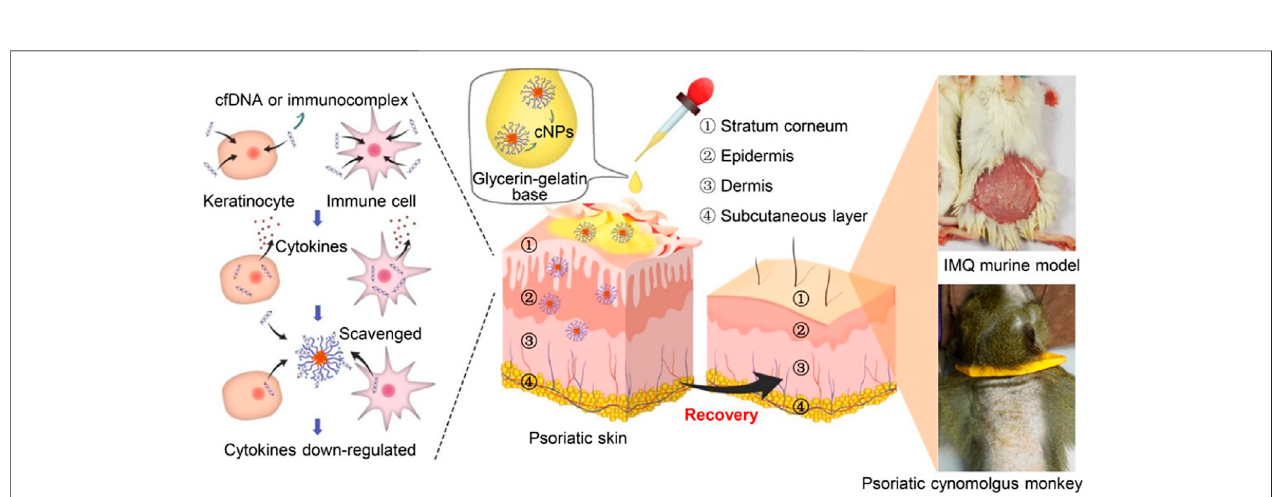
Frontiers in Pharmacology |